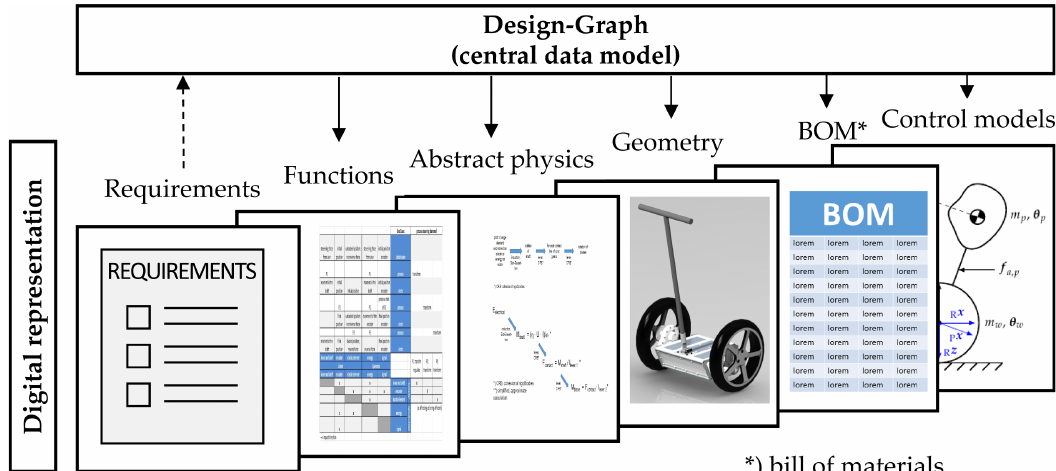
Figure 5. Design graph with digital